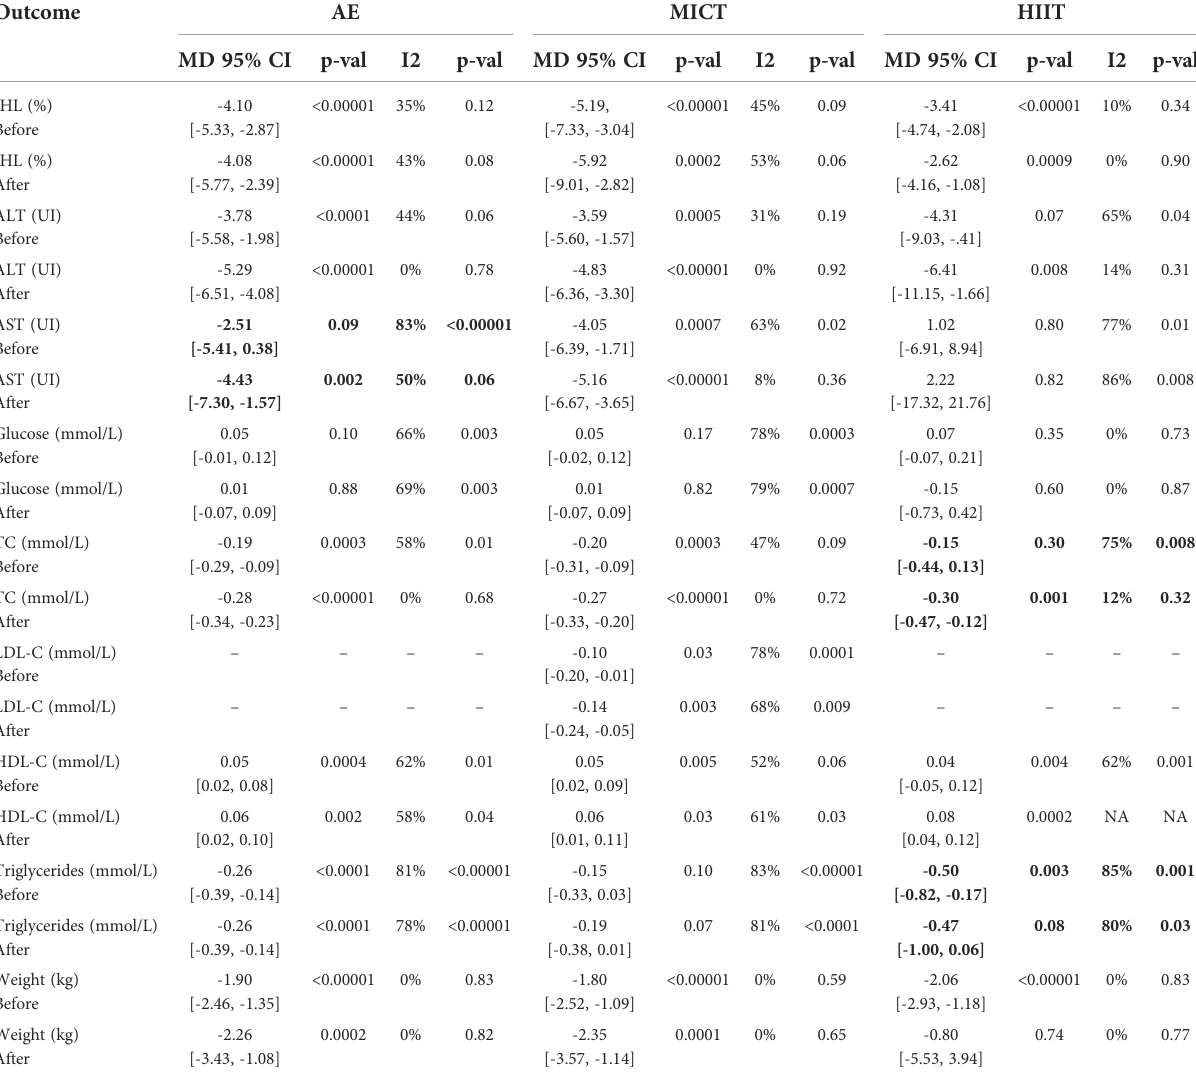
TABLE 3 Results of meta-analyses before and after sensitivity analysis including mean difference (MD), 95% CI and signi fi cance level, as well as heterogeneity (I2) and signi fi cance level per intervention type, consisting of studies with similar intervention duration excluding study by Zhang et al.